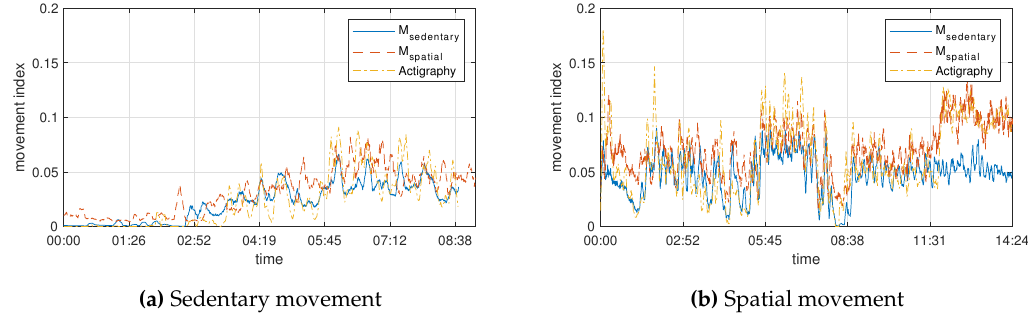
Figure 5. Graph of results when measured simultaneously with actigraphy. ( a ) and ( b ) are the results for sedentary and spatial movement, respectively. Actigraphy was scaled because the unit of the result data was not an actual physical